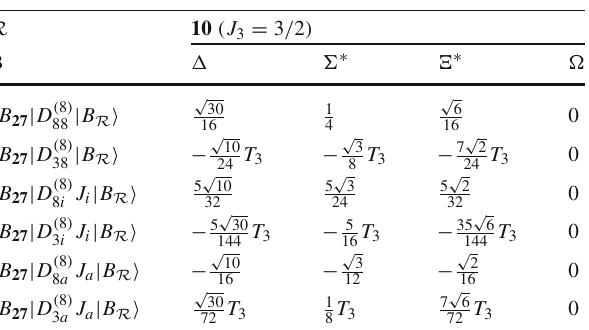
Table 7 The relevant transition matrix elements of the collective oper- ators coming from the 27plet component of the baryon wavefunctions for the electric monopole form factors